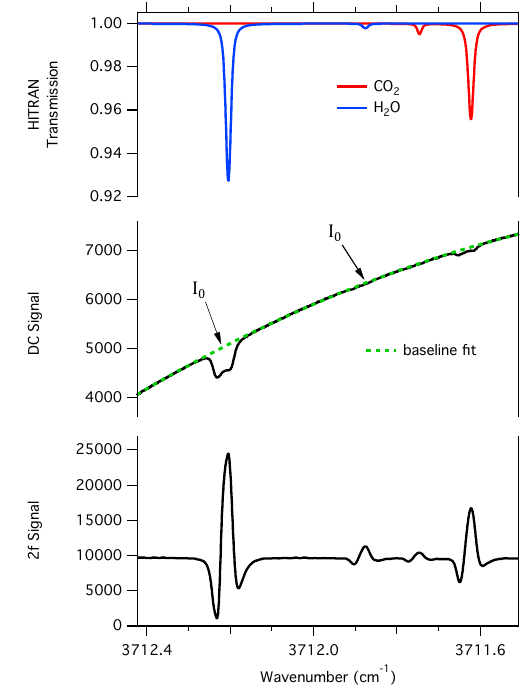
Figure 4. Top: HITRAN calculation of transmission through the detection cell with 100ppm H 2 O (blue) and 370ppm CO 2 (red). Middle: 1s coaveraged DC spectrum in the WV channel from the final descent on 27 February 2013 at an ambient H 2 O mixing ratio of approximately 100ppm. The green dashed line is the polynomial fit to the baseline for determination of the I 0 values at the strong and weak H 2 O absorption lines. Bottom: corresponding 1s coaveraged 2f spectrum. Note that the scan is plotted as it is recorded in time and the wave number scale decreases from left to